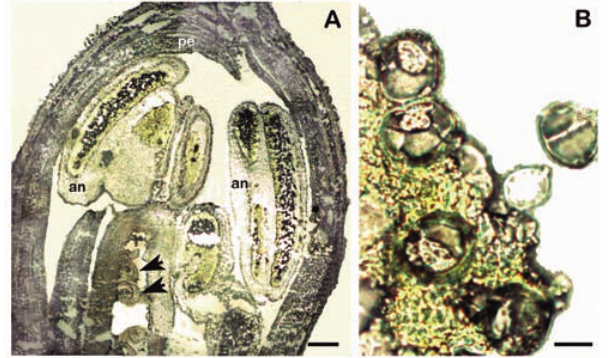
Fig. 5 - Flower in pre anthesis phase of Moringa oleifera Lam. (frozen section). A, Longitudinal section of flower with petals (pe), anthers (an) and ovary with ovules (arrows); B, mature pollen grain surrounded by sporopollenin. Bars = A, 10 cm; B, 10 µm.